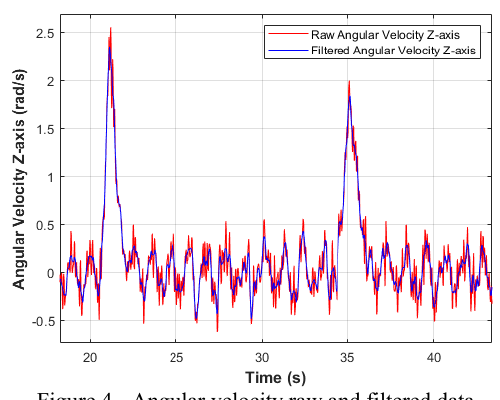
Figure 4 - Angular velocity raw and filtered